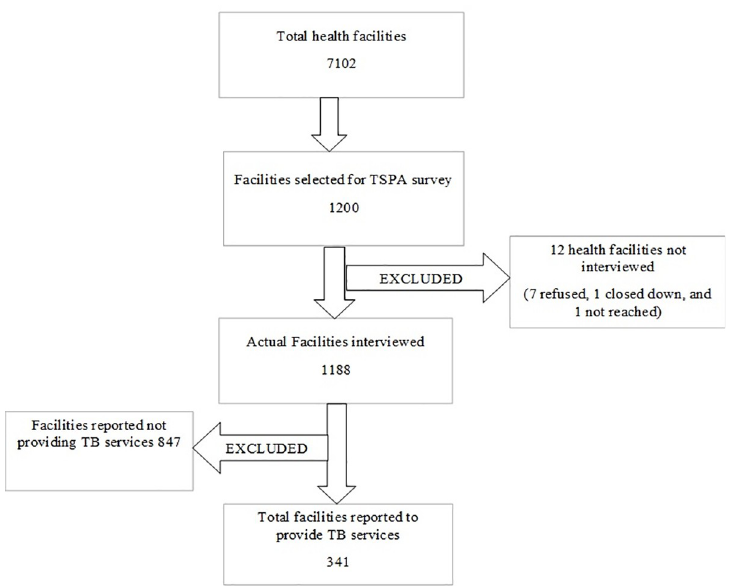
Fig 1. Selection of health facilities included in the current